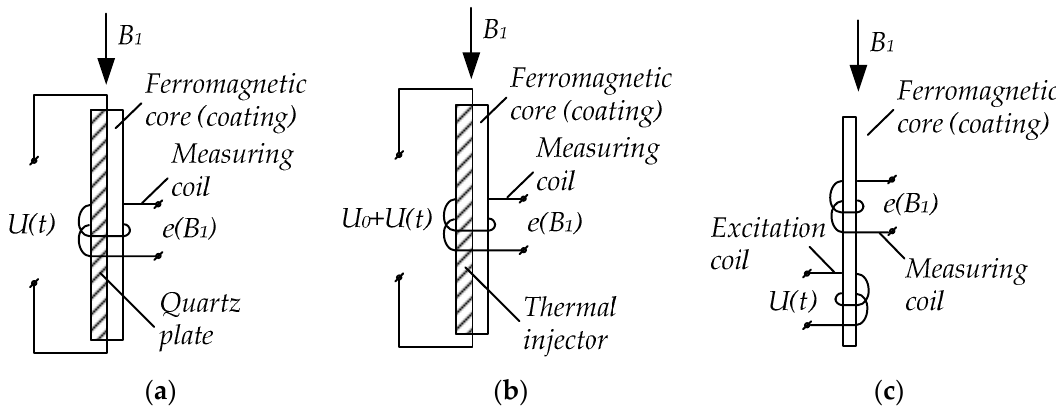
Figure 1. Fluxgate converters with mechanical ( a ), thermal ( b ), and magnetic ( c ) excitation.